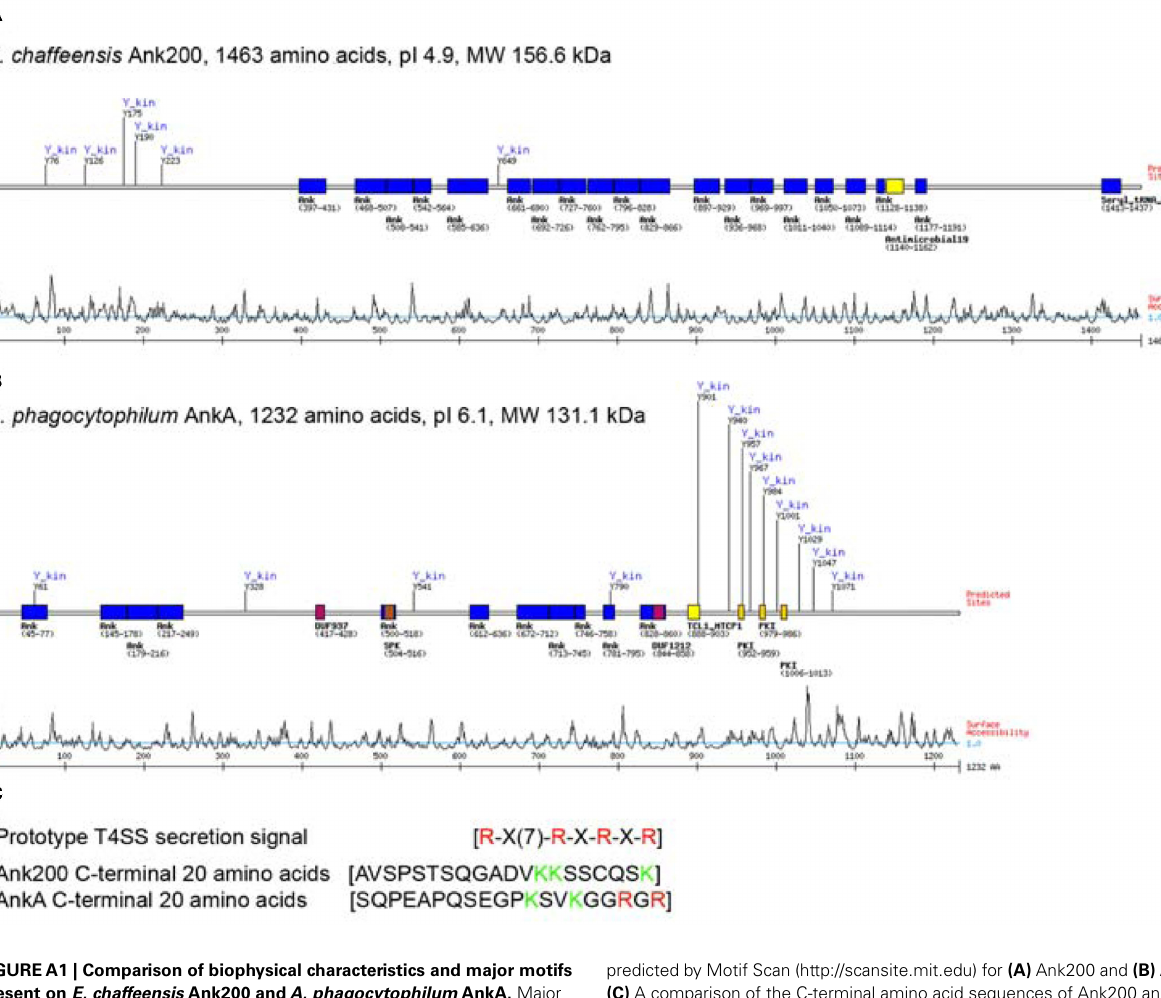
predicted by Motif Scan (http://scansite.mit.edu) for (A) Ank200 and (B) AnkA. (C) A comparison of the C-terminal amino acid sequences of Ank200 and AnkA with prototypeT4SS signal